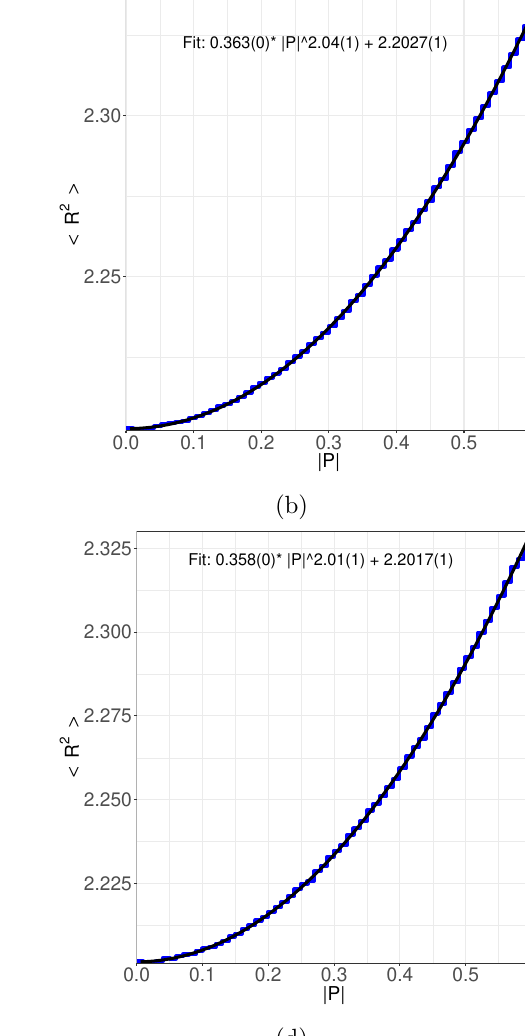
Figure 17. Several checks of the partial decon(cid:12)nement prediction for h E i ( j P j ) and The blue curve shows binned values for 0 (cid:20) j P j (cid:20) 0 : 5. a+b) N = 48, L = 24, c+d) N = 64, L = 24; all T = 0 : 885, D = 10.